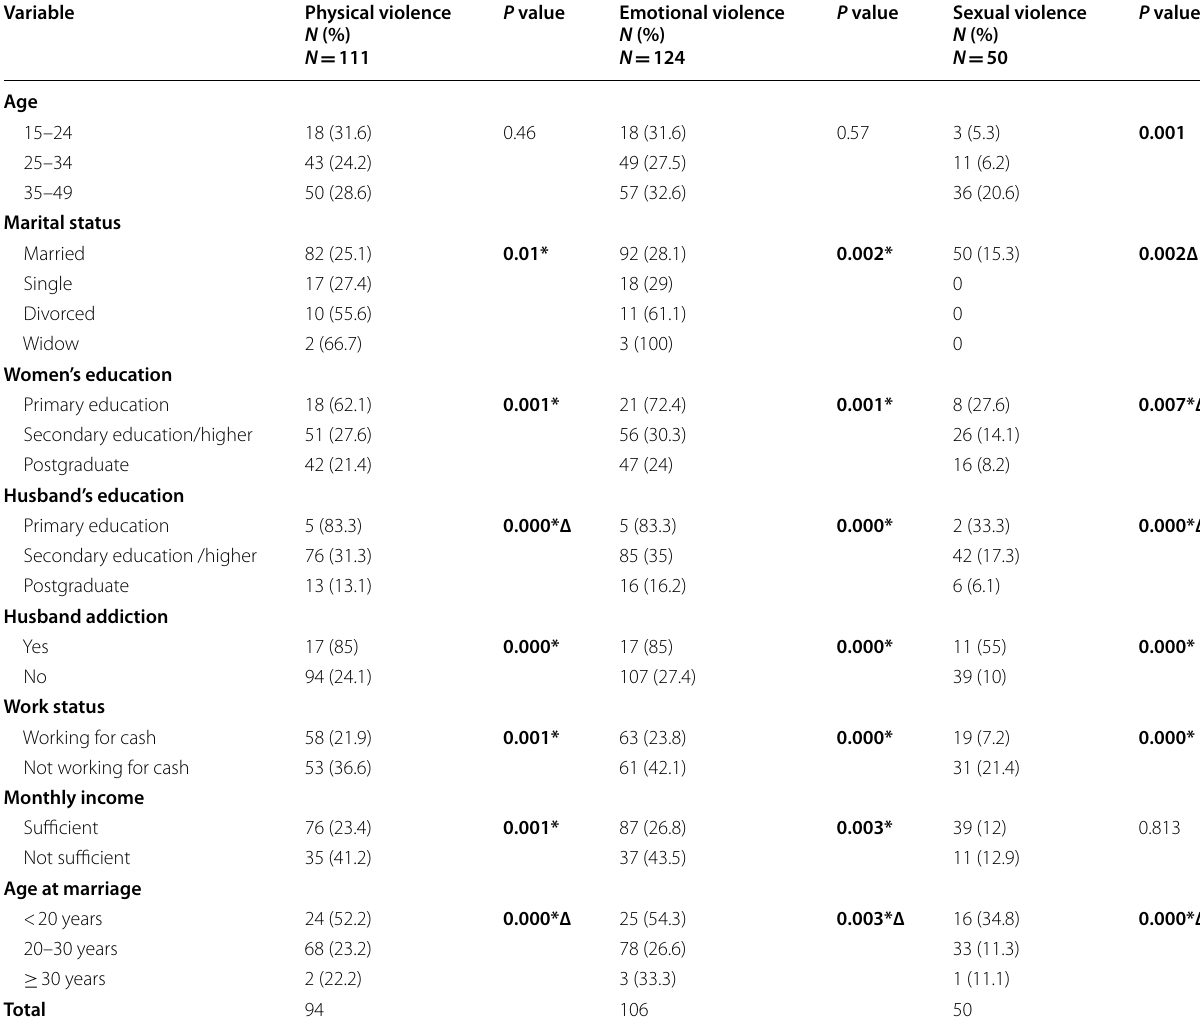
Table 4 Relationship between the socio‑demographic characteristics and women’s exposure to different forms of violence,